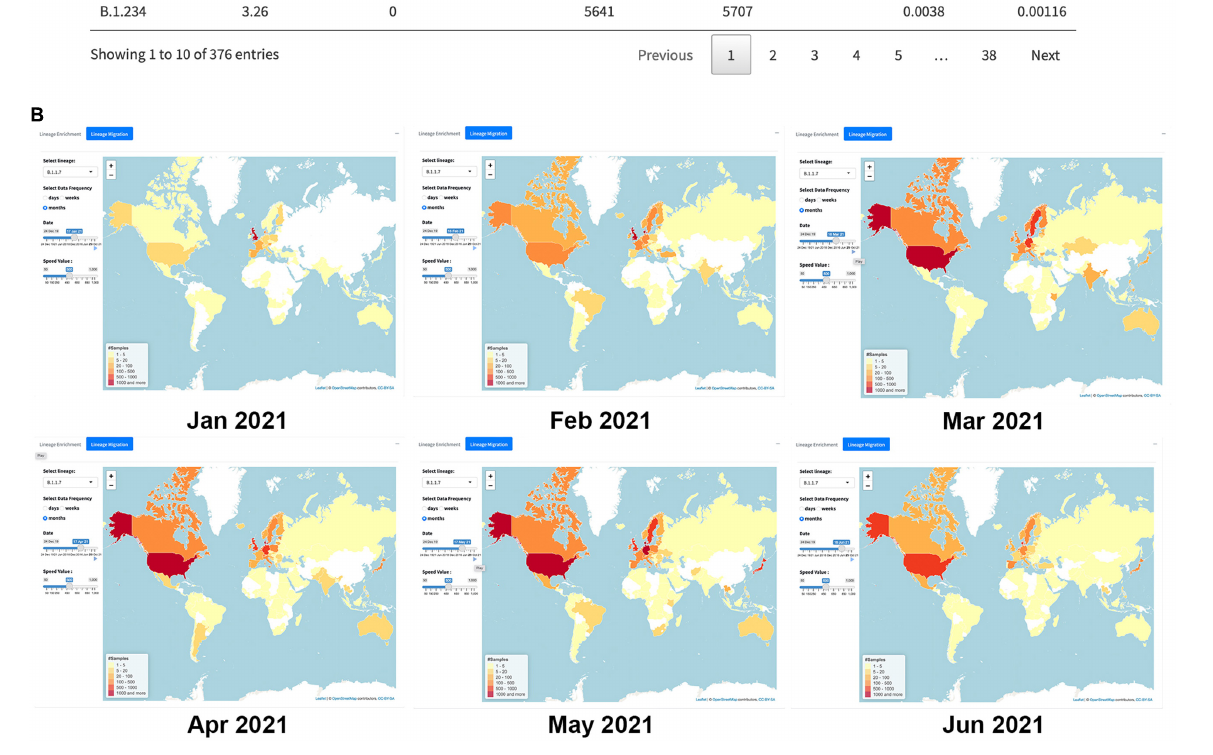
FIGURE 6 | The overall look of the “Lineage Analysis.” (A) An example of “Lineage Enrichment” results in the United States with the cutoffs, F.E. > 2, and FDR < 0.05. (B) “Lineage Migration” patterns for B.1.1.7 (i.e., alpha); six key frames correspond to the time from January 2021 to June 2021 captured from the animated lineage migration map, indicating that the variant spread to the world from January to May 2021, then started to disappear since June 2021.